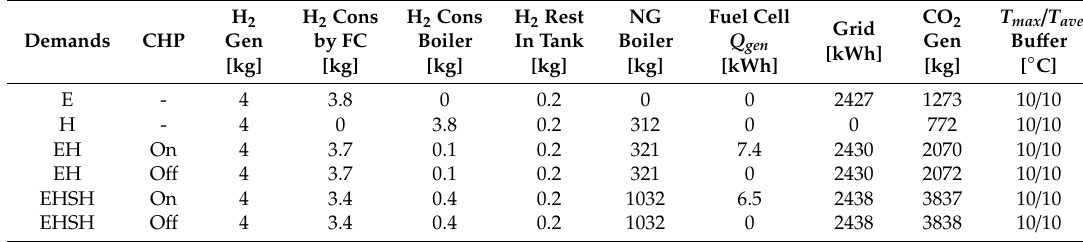
Table 6. System analysis with TiO 2.